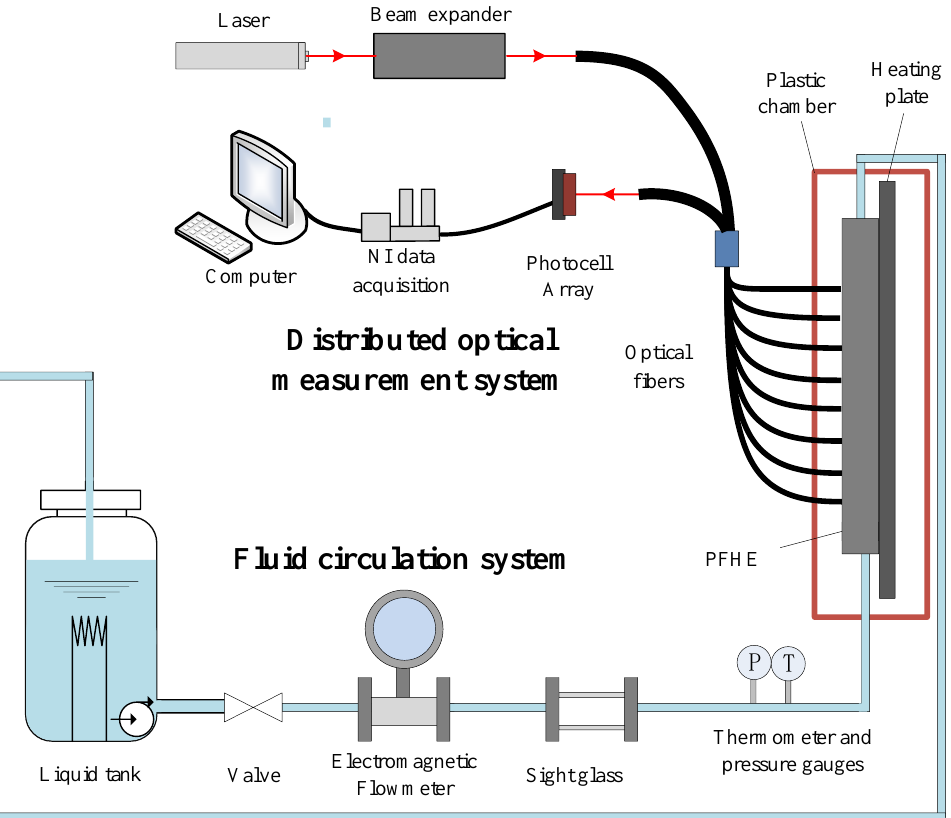
Figure 6. Experimental setup of the blow boiling in PFHE.